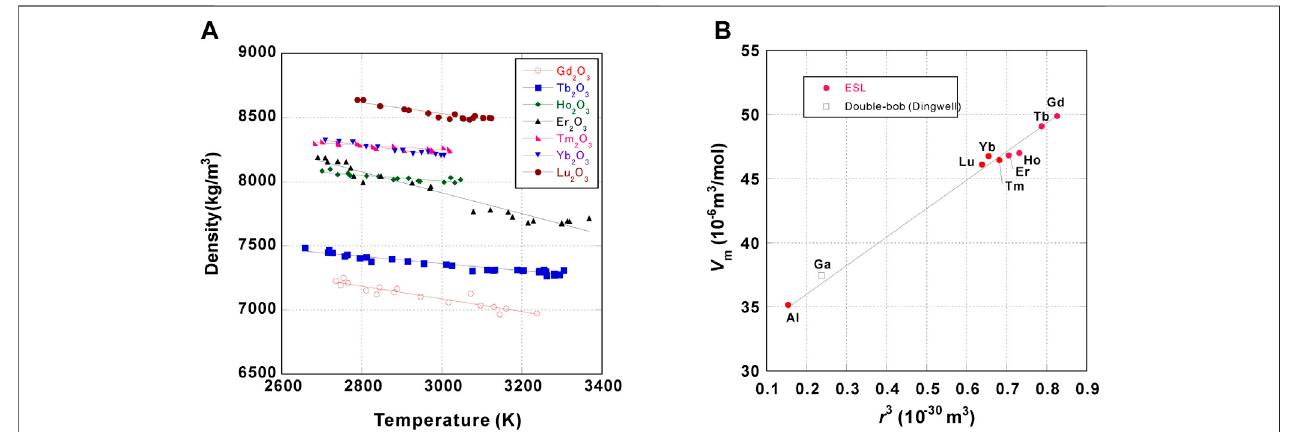
FIGURE 4 | (A) Density of molten lanthanoid sesquioxides as a function of temperature measured by the ISS-ELF. The correlation coef fi cient (R) for each measurement is0.94forGd